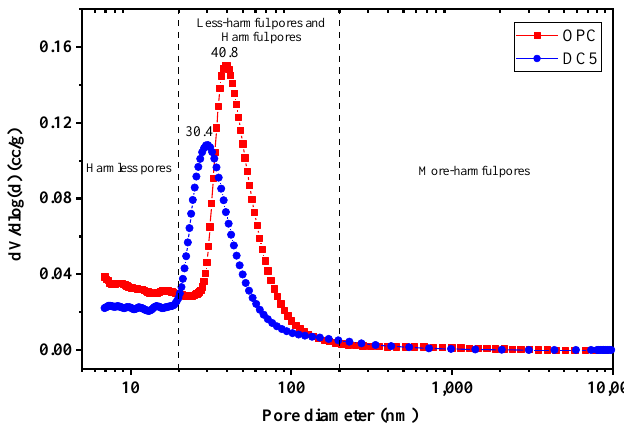
Figure 13. Pore size distribution of samples.